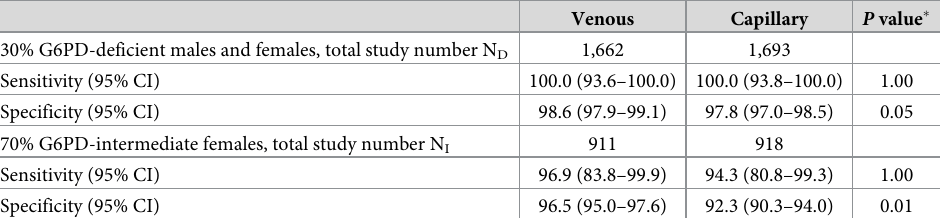
Table 4. Diagnostic performance of the STANDARD G6PD Test using the manufacturer’s thresholds compared with normalized spectrophotometric reference values, by specimen type.